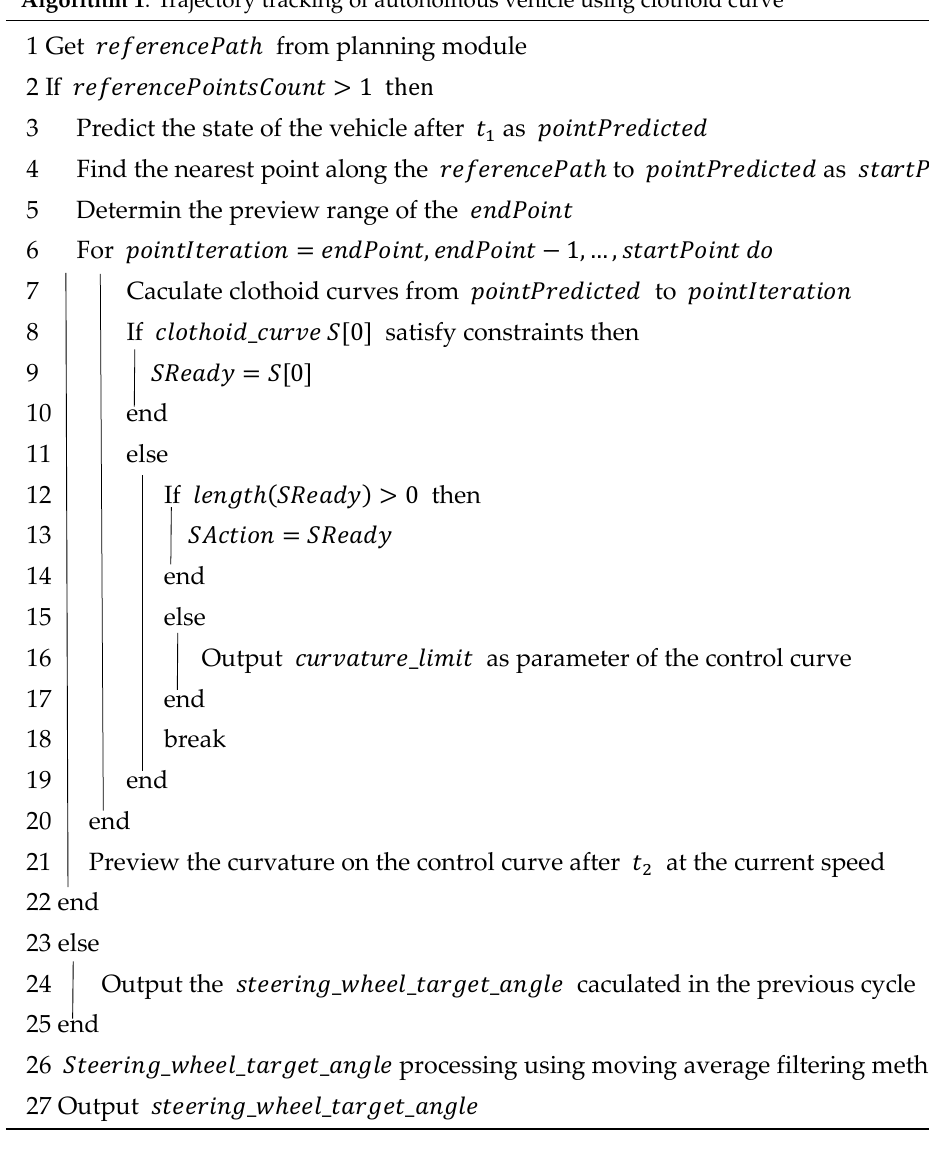
Table 1. The overall algorithm flow 1. Algorithm 1 : Trajectory tracking of autonomous vehicle using clothoid curve Algorithm : Trajectory tracking of autonomous vehicle using clothoid